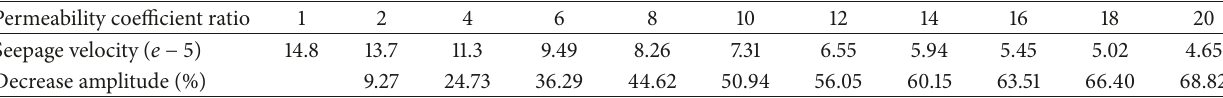
Table 3: The amplitude of the seepage velocity decreases.